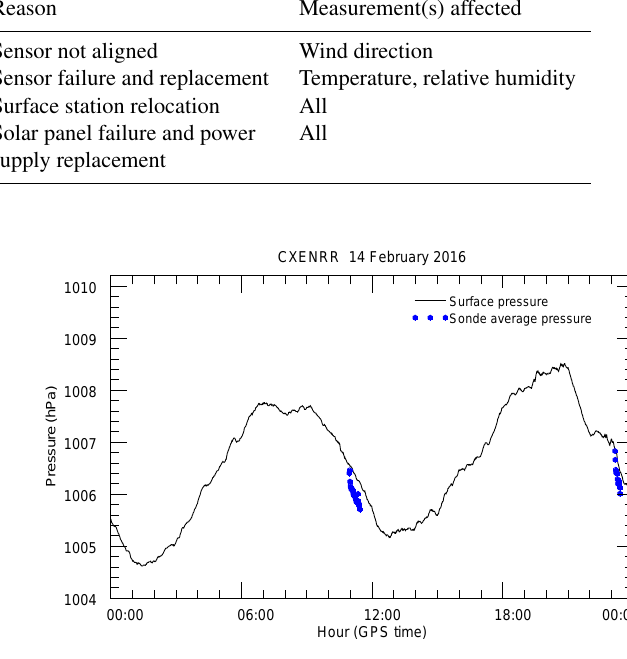
Figure 6. Surface pressure measured at Kiritimati by the PTB101B (1min resolution) on 14 February 2016 together with pressures measured by the day’s two radiosondes prior to launch (1min av- erages). The first two points of the averaged radiosonde data are omitted; one is a partial average beginning just after the radiosonde was powered up on the battery, and the second was from inside the room rather than outdoors on the datalogger